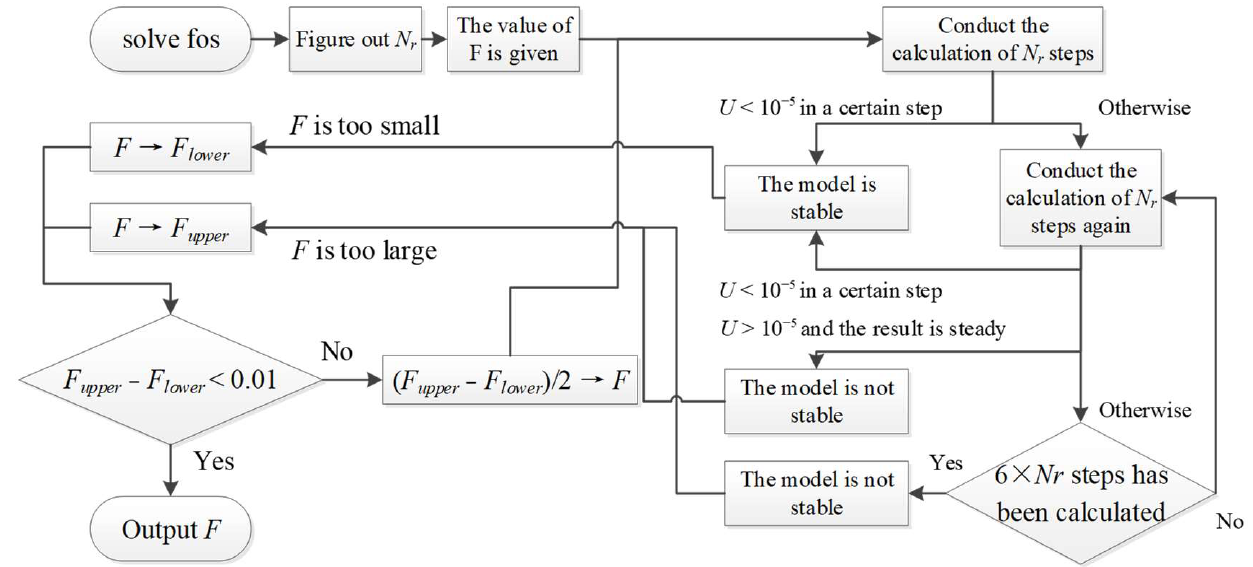
Figure 2. Solving the safety factor in numerical simulation.